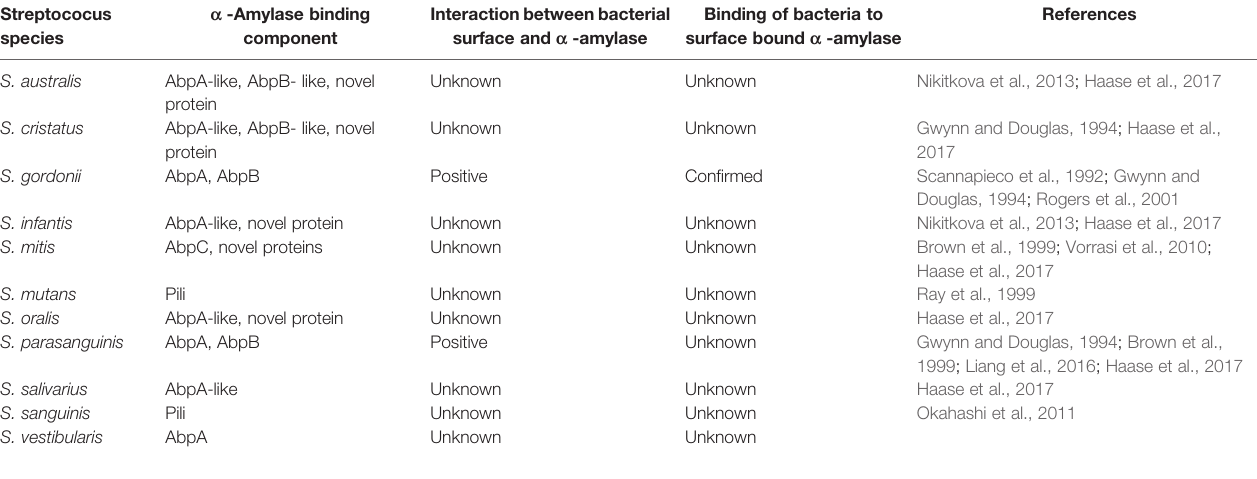
TABLE 3 | Streptococcal proteins interacting with salivary